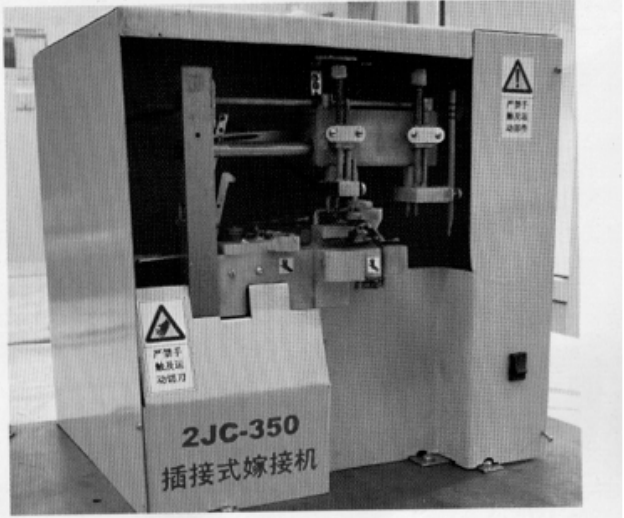
Figure 6. 2JC-350 plug-in semi-automatic grafting robot developed by Northeast Agricultural University. Table 3. Comparison of the Characteristics of the Vegetable Grafting Robots Based on Insertion Grafting.